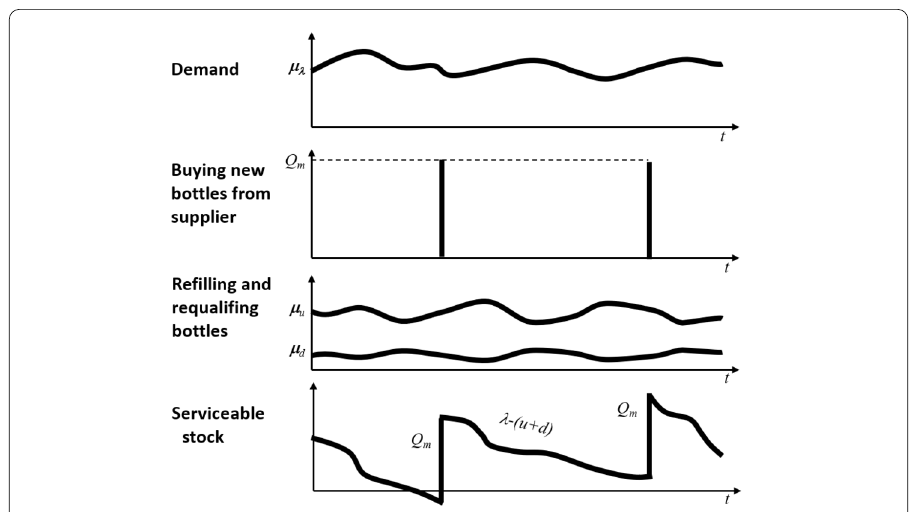
Figure 8 Stochastic inventory stock model S